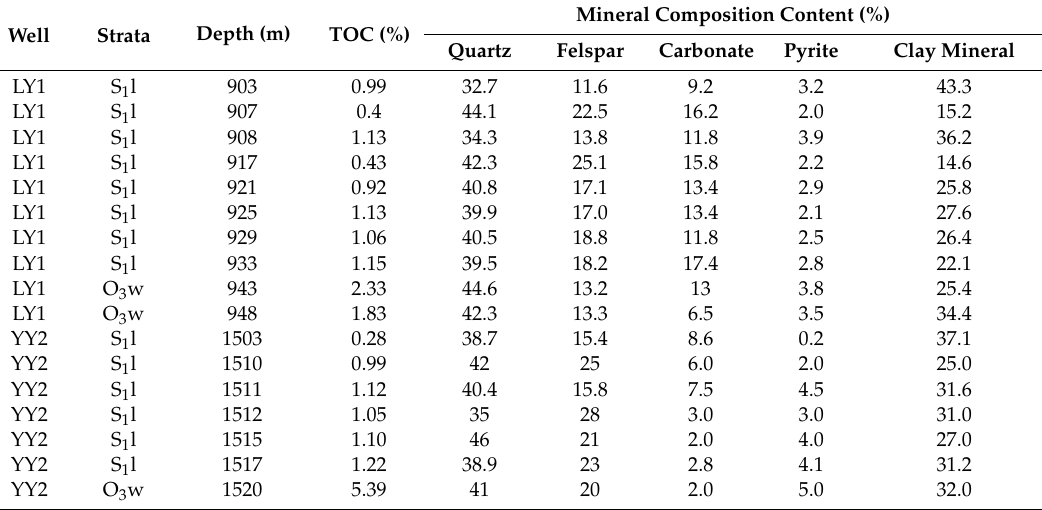
Table 1. The mineralogical composition of 17 samples from well LY1 and well YY2 was derived based on the XRD